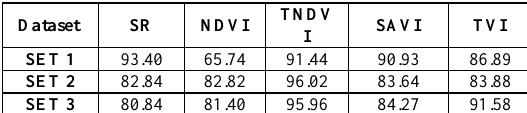
Table 4: Image to image overall accuracy of data sets for five indices using noise